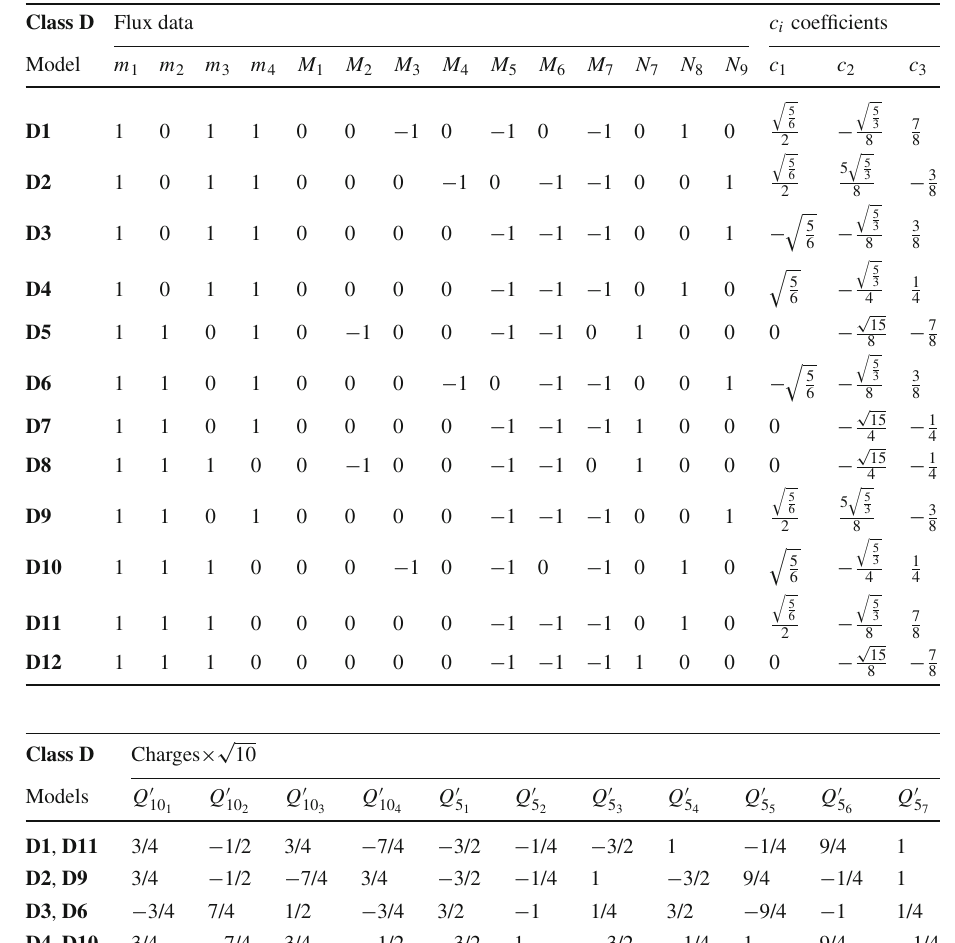
Table 16 Class D models flux data